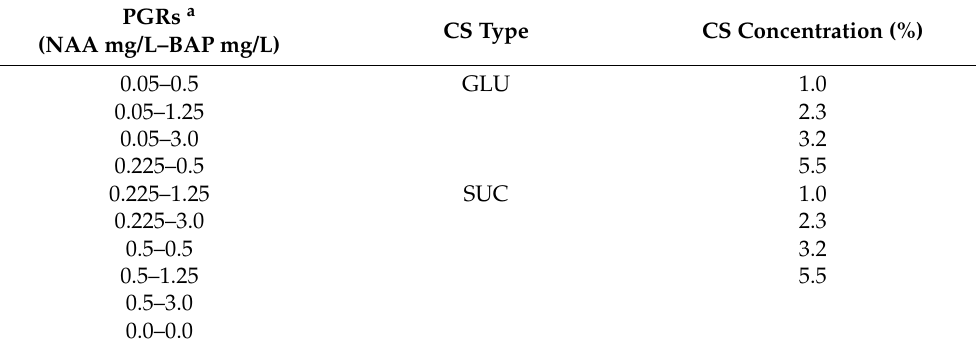
Table 1. Plant growth regulators (PGRs; 1-Naphthaleneacetic acid (NAA) and 6-Benzylaminopurine acid (BAP) in combination) and carbon source (CS) type and concentration in the experimental design for Taraxacum’s germination studies as proposed in this